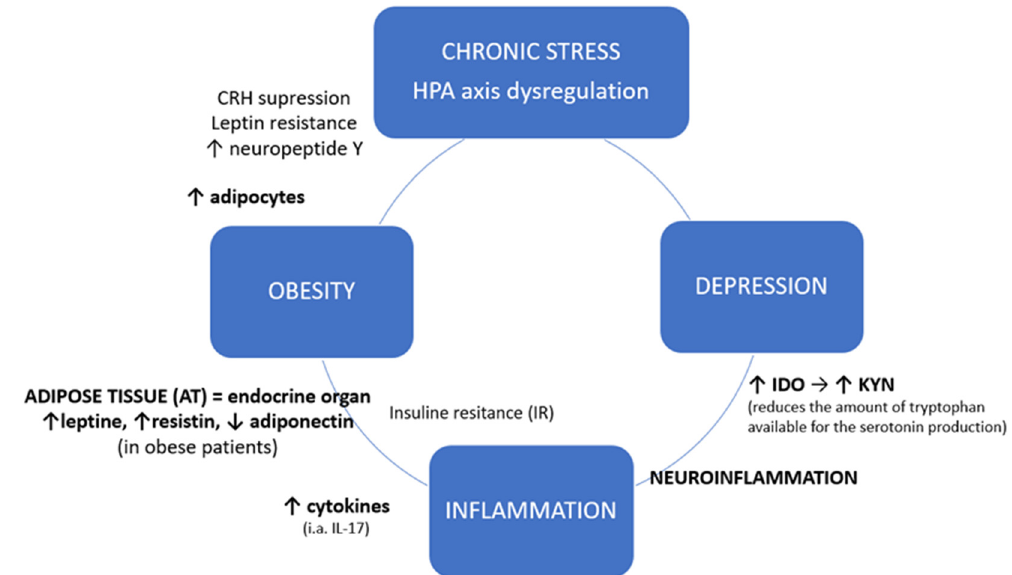
Figure 1. Chronic stress and inflammatory crosslink between obesity and depression. HPA axis: hypothalamic-pituitary-adrenal axis; CRH: Corticotropin-releasing hormone, corticoliberin; IDO: Indoleamine-pyrrole 2,3-dioxygenase; KYN: Kynurenine.